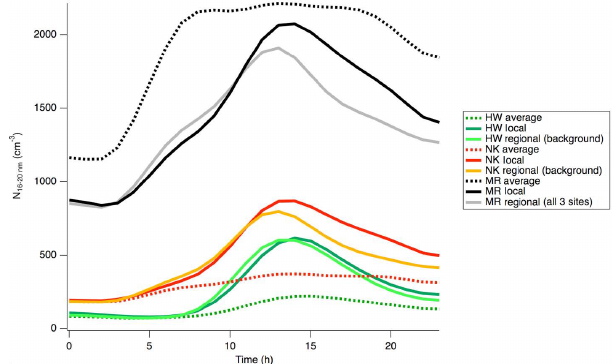
Figure 4. Diurnal variation of N 16–20nm at each site: annual mean and NPF event